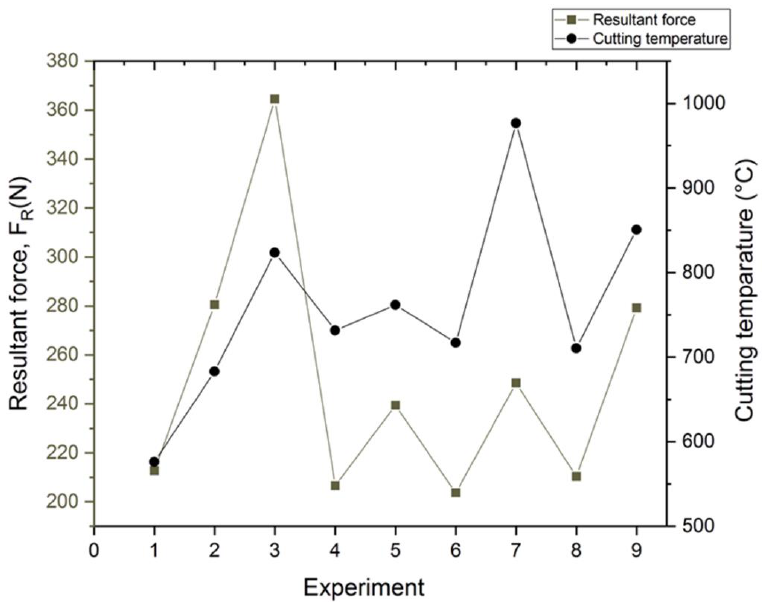
Figure 7. The resultant force and cutting temperature for the nine experiments under cryogenic